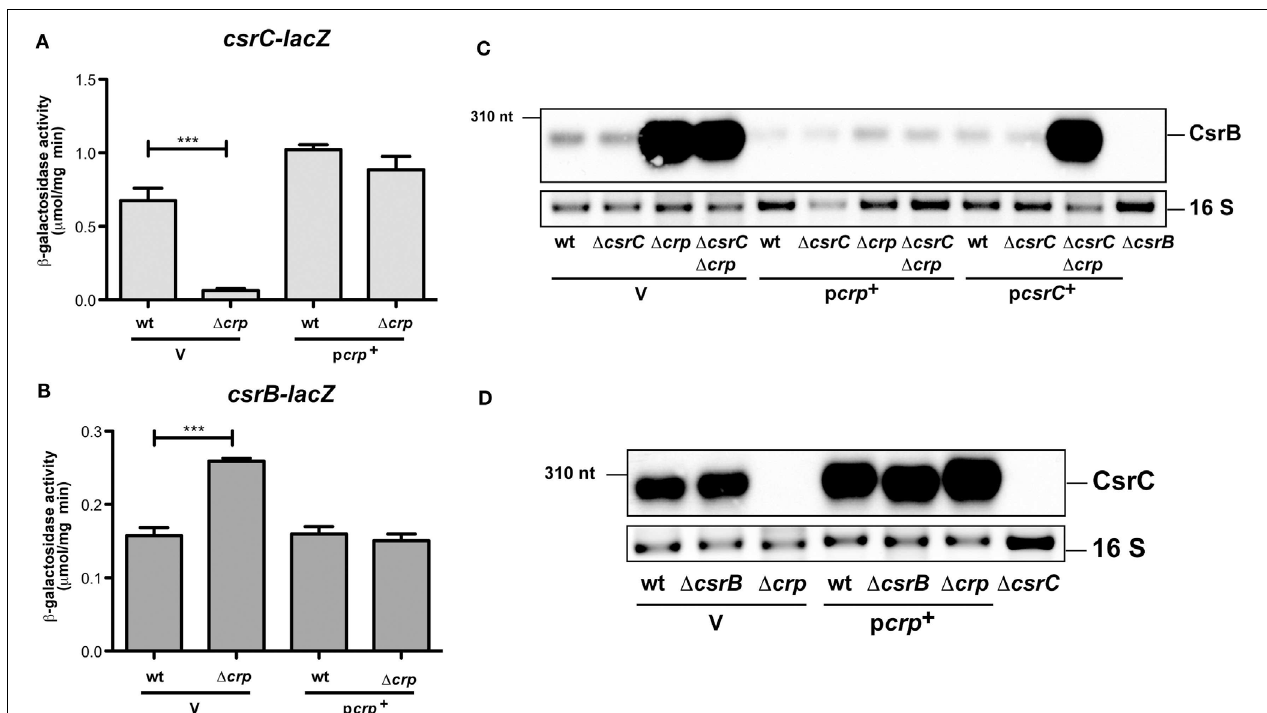
( ∆ crp ),YP126 ( ∆ csrC ), andYP127 ( ∆ crp ∆ csrC ) harboring the empty vector pAKH85 (V) or the crp -encoding plasmid pAKH37 or csrC -encoding plasmid pAKH59 grown at 25˚C were prepared, and analyzed by northern blotting with a CsrB-specific probe.YP69 ( ∆ csrB ) was used as negative control. (D) Analysis of CsrC production upon overexpression of Crp in the presence or absence of csrB .Total RNA from cultures of Y. pseudotuberculosis wildtype strainYPIII and the mutant strainsYP89 ( ∆ crp ),YP69 ( ∆ csrB ), andYP89 ( ∆ crp ) harboring the empty vector pAKH85 (V) or the crp -encoding plasmid pAKH37 grown at 25˚C was prepared, and analyzed by northern blotting with a CsrC-specific probe. YP126 ( ∆ csrC ) was used as negative